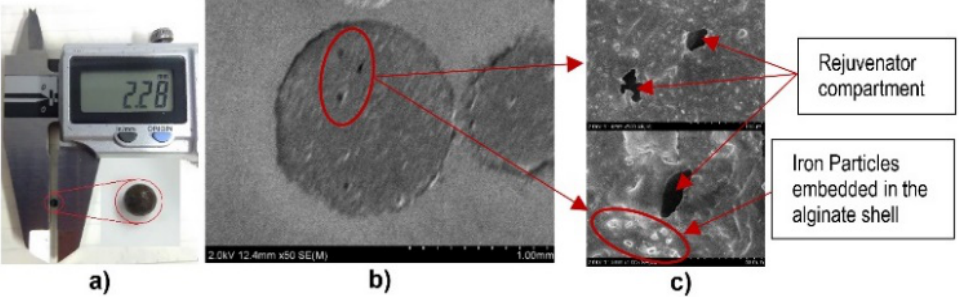
( d ) Figure 10. SEM capsule images: ( a ) Alg 70:Fe30; ( b ) Alg 50:Fe 50; ( c ) Alg 30:Fe 70; ( d ) Alg 20:Fe 80. Figure 11 illustrates the bitumen rejuvenating pockets within the capsule structure. It is clear from the images that the alginate/iron power ratio has no significant influence on the size of the oil pockets within the capsule. This is in agreement with the findings from the literature [16,17], where it is stated that capsule size is dependent on the mixing rate and less on the oil content. The reduction in the oil content in the mix is due to the reduction of alginate in the mix. With increasing the iron powder content, the alginate